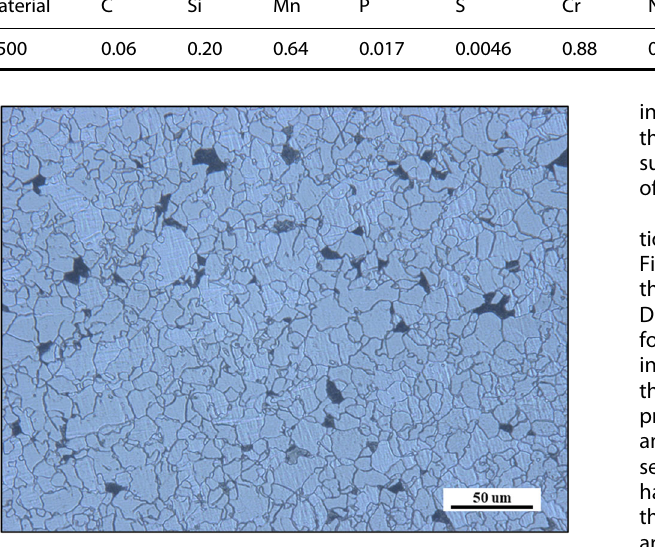
Fig. 1 Microstructure of pearlite and ferrite of low-alloy steel